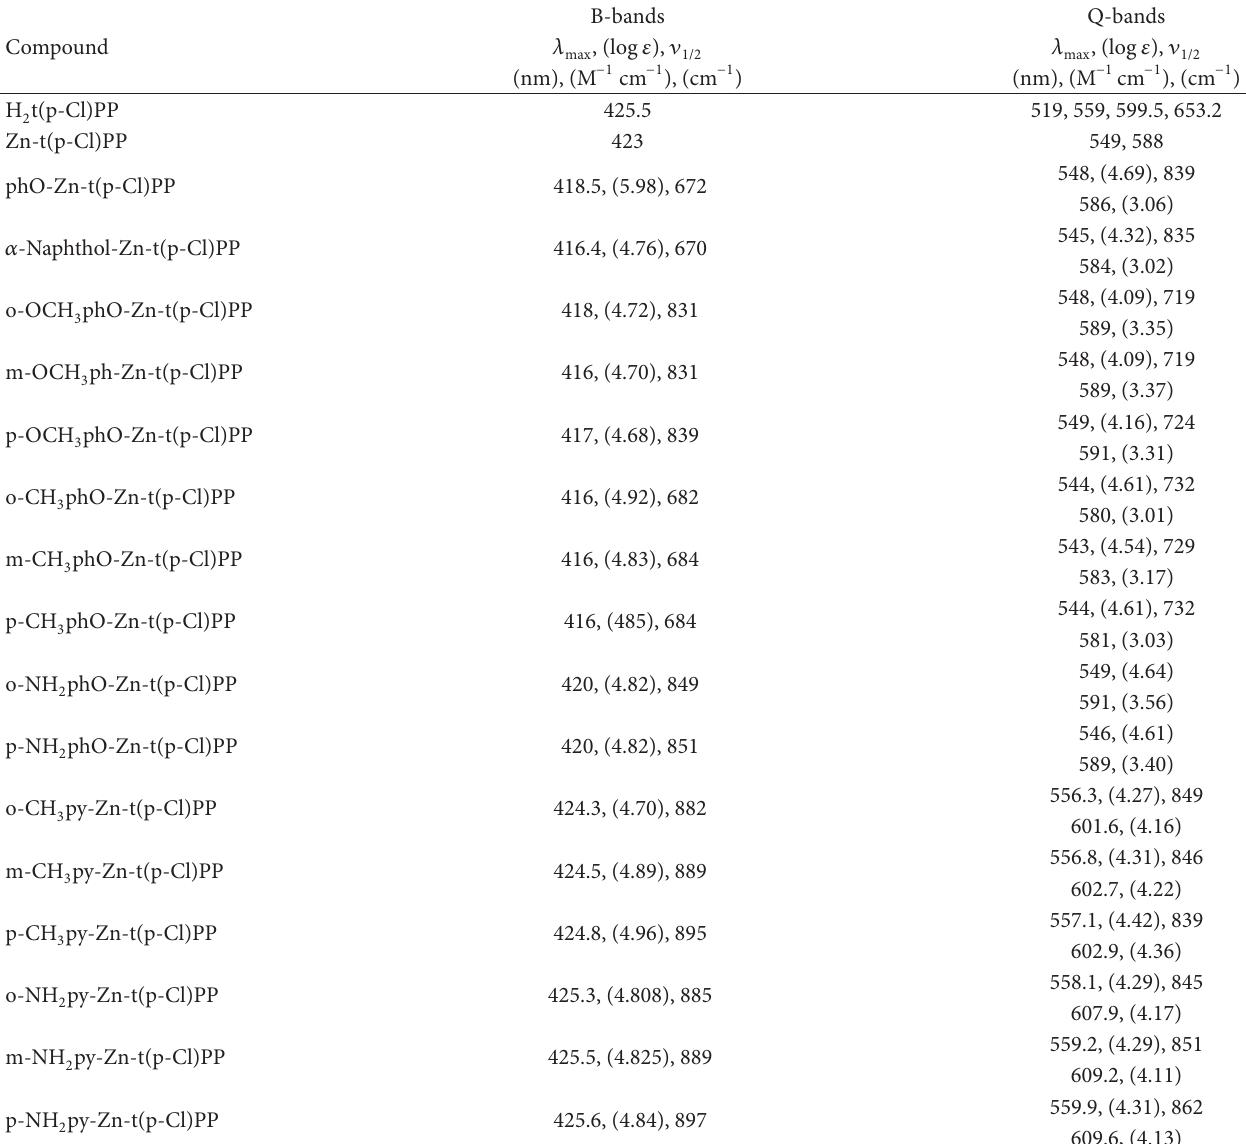
T 3: Optical absorption data of X-Zn II -t(p-Cl)PP (X = phenolates and pyridinates as axial ligands) in CHCl